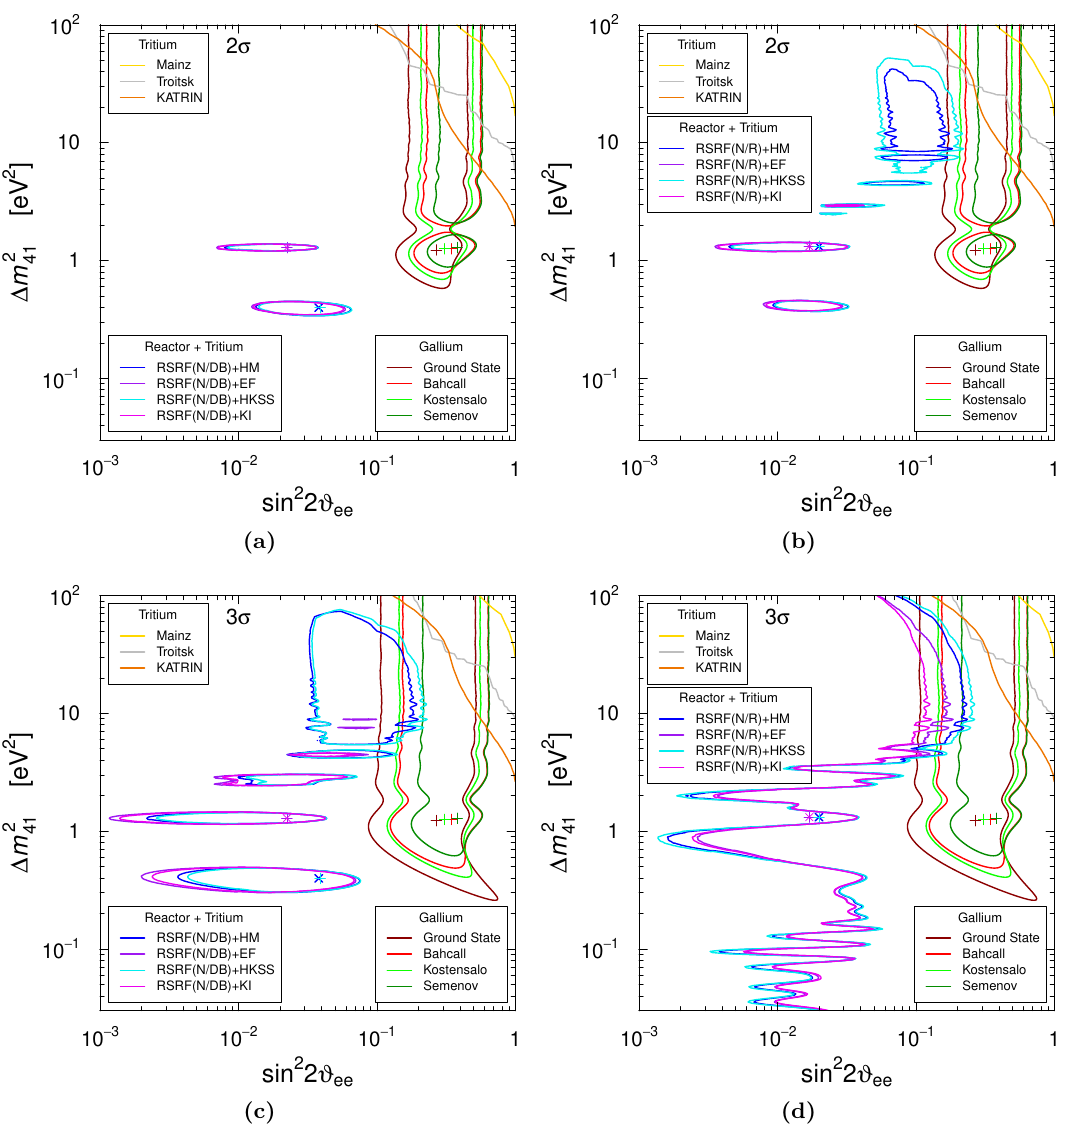
Figure 7. Comparison of the contours delimiting the [(a) and (b)] 2 σ and [(c) and (d)] 3 σ allowed regions in the ( sin 2 2 ϑ ee , ∆ m 2 ) plane obtained from the combined analysis of the data of the 41 reactor rate experiments with different flux models, the spectral ratio experiments, and the Tritium experiments with those obtained from the Gallium data with different cross sections. The figures differ by the use of [(a) and (c)] NEOS/Daya Bay [45] or [(b) and (d)] NEOS/RENO [46] spectral ratio data. The best-fit points are indicated by